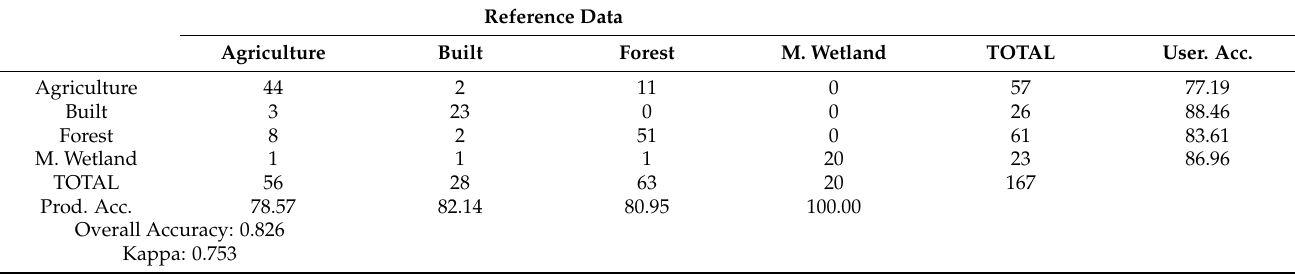
Table A3. Confusion matrix and user and producer’s errors of the Random Forest (RF)